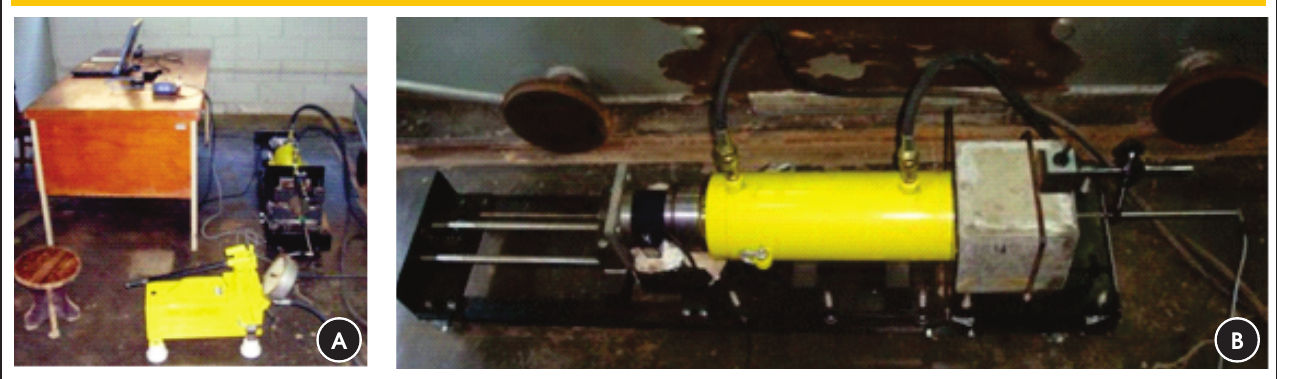
Figure 7 – Schematic of the POT test method